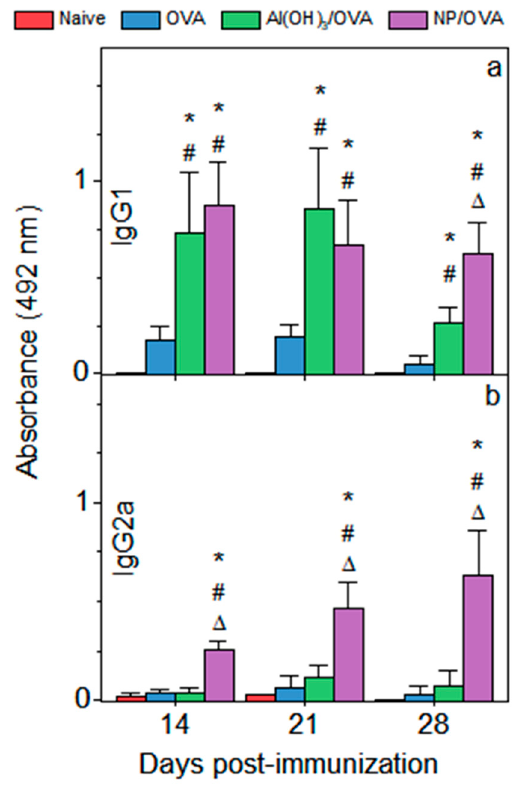
Figure 5. Antibody production in sera on days 14, 21 and 28 after immunization as induced by ovalbumin (OVA), Al(OH) 3 /OVA and NPs/OVA. The mean absorbance measured at 492 nm ± standard deviation was relative to the production of OVA-specific IgG1 ( a ) or IgG2a ( b ). Serum dilution to present IgG1 primary response was 1/1024 and IgG2a primary response was showed at 1/32. Secondary response of IgG1 was displayed at 1/512,000 whereas IgG2a secondary response was presented at 1/512. p < 0.05 compared to the naive group (#), p < 0.05 compared to the OVA group (*), p < 0.05 compared to the Al(OH) 3 /OVA group ( ∆